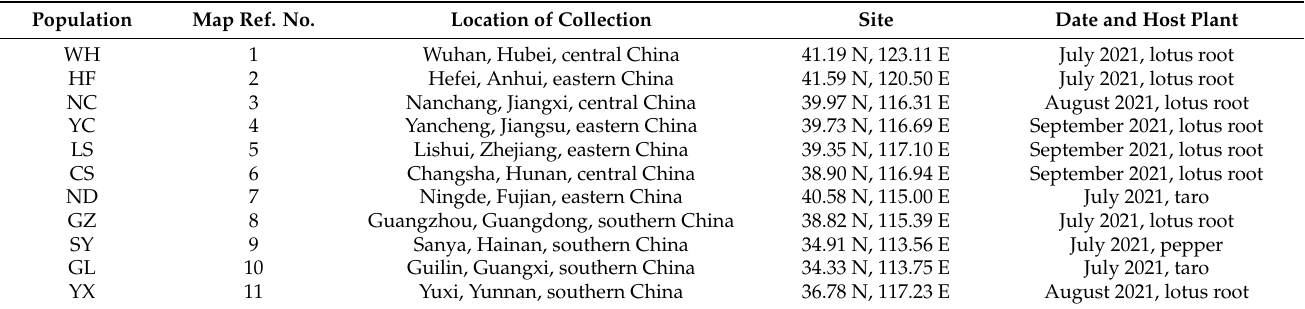
Table 1. Detailed information on collected S. litura field populations.